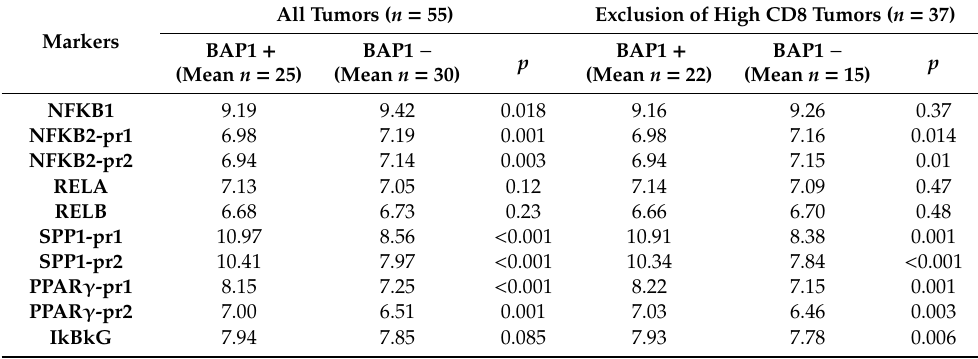
Table 5. Correlation between BAP1 staining as defined by immunohistochemical staining and NFkB pathway molecules expression in all tumors for which BAP1 staining was available ( n = 55) and again after exclusion of one-third of the tumors with the highest infiltrate, based on CD8 expression ( n = 37). One-Way ANOVA was used to calculate the means. p ≤ 0.05 is considered